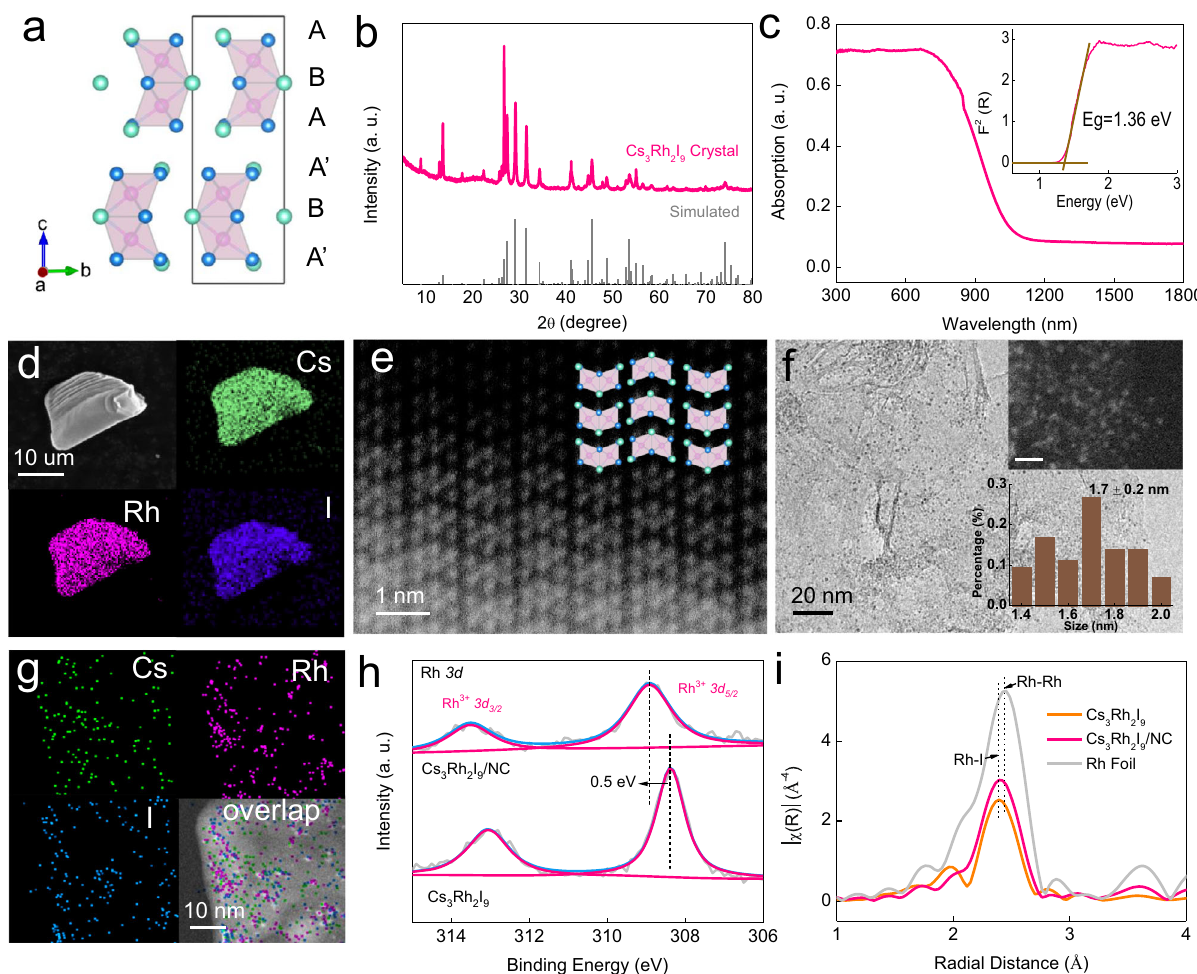
Fig. 2 | Structure characterizationof bulkCs 3 Rh 2 I 9 and nanoclusters Cs 3 Rh 2 I 9 / NC. a Atomic structure, and ( b ) powder XRD pattern and simulated pattern of Cs 3 Rh 2 I 9 crystal. c Diffuse-re fl ectance UV – Vis spectrum of Cs 3 Rh 2 I 9 . The inset showsthecorrespondingTaucplot. d SEM-EDXmappingimagesofCs 3 Rh 2 I 9 single crystal. e HAADF-STEM image of Cs 3 Rh 2 I 9 crystal. f TEM image of Cs 3 Rh 2 I 9 clusters